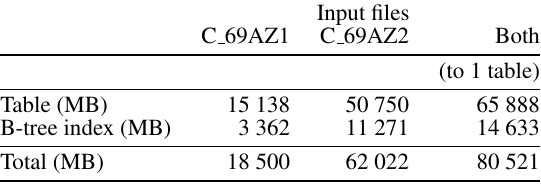
Table 3. Resulting sizes of the database structure (table and index) with SFC key and cLoI attribute added per point.